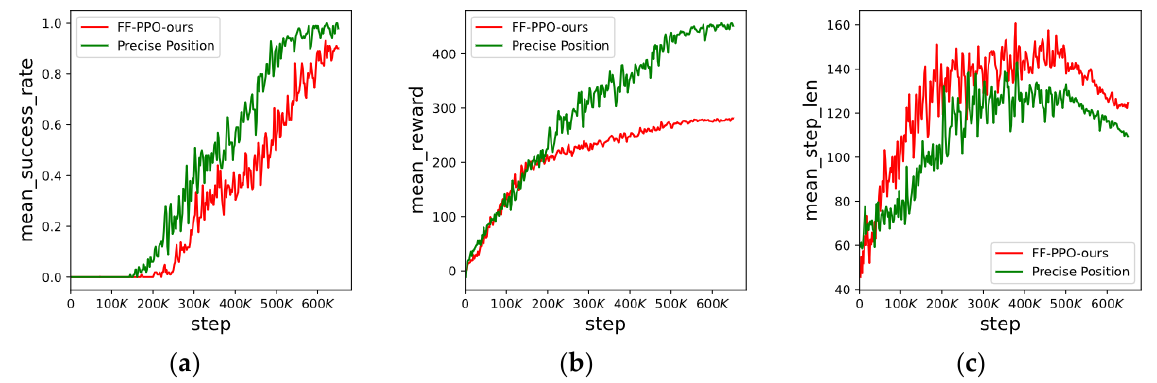
Figure 11. Training process. The horizontal axis is the number of training steps. ( a ) is the success rate curve, ( b ) is the reward curve, and ( c ) is the step length curve.